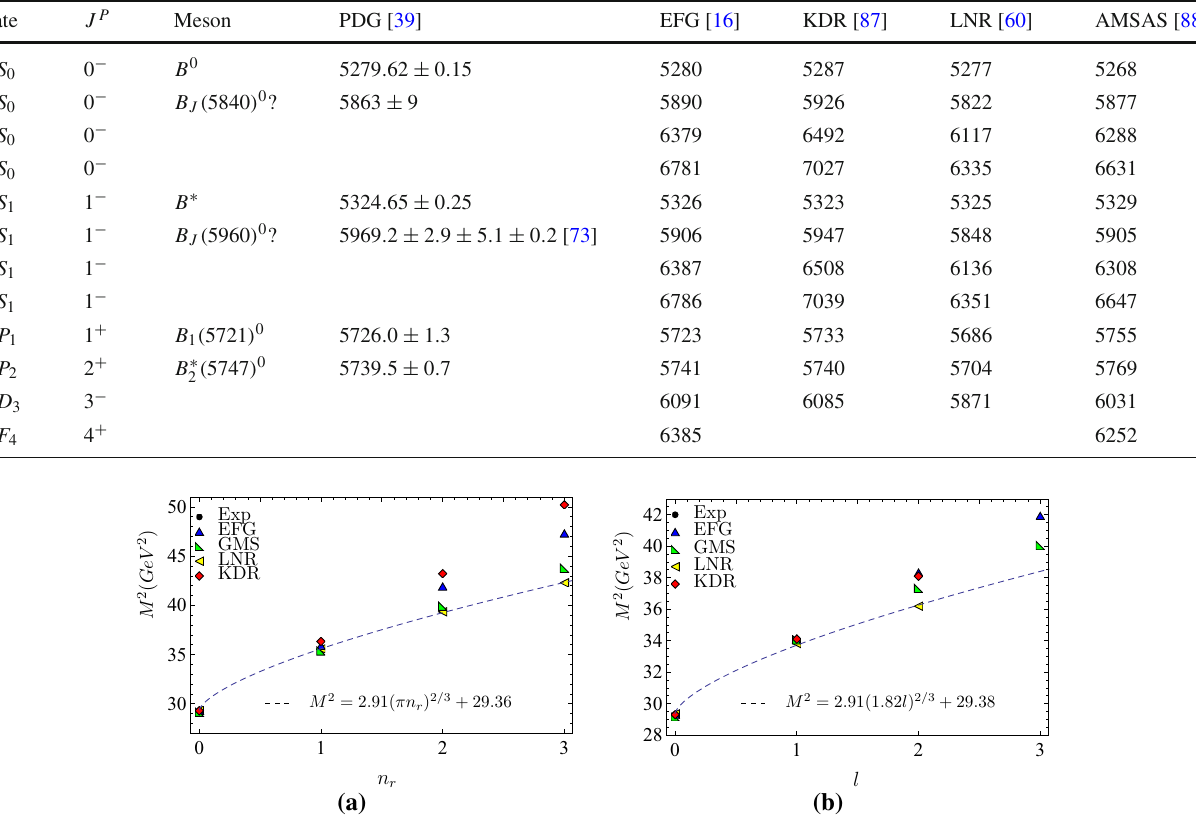
Fig. 6 (Color online) The radial and orbital Regge trajectories for the bottom-strange mesons. The theoretical data are from Ref. [16] (EFG), [89] (GMS), [87] (KDR) and [60] (LNR). The experimental data (Exp) are from Ref. [39]. The dashed lines are the Regge trajectories by fitting the theoretical values in